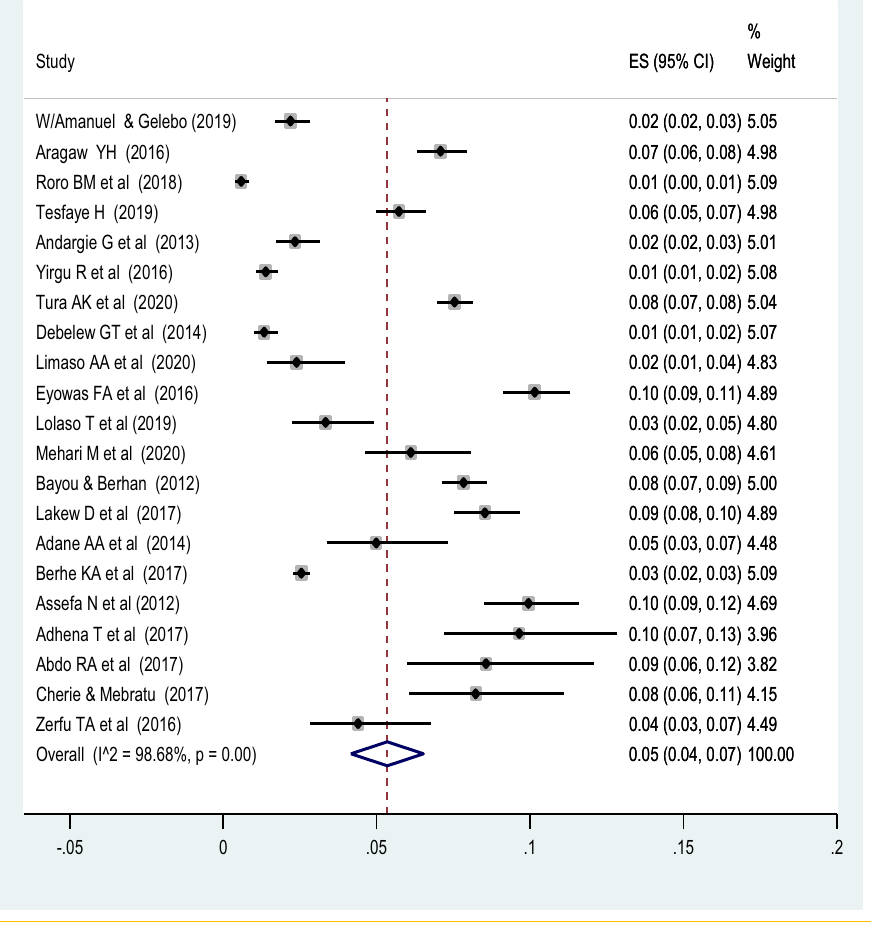
Figure 4. Forest plot on the pooled prevalence of stillbirth in Ethiopia: